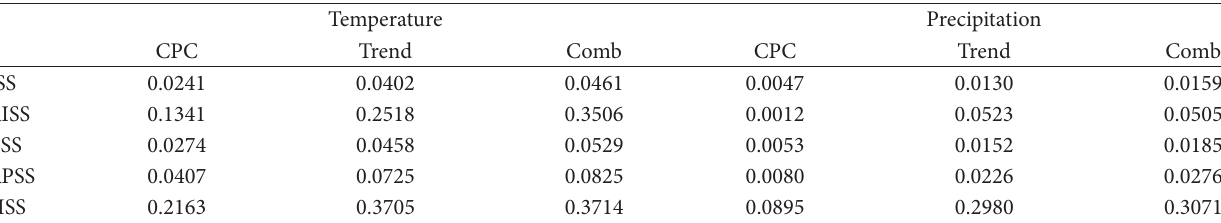
T 2: Skill scores for forecasts and trend